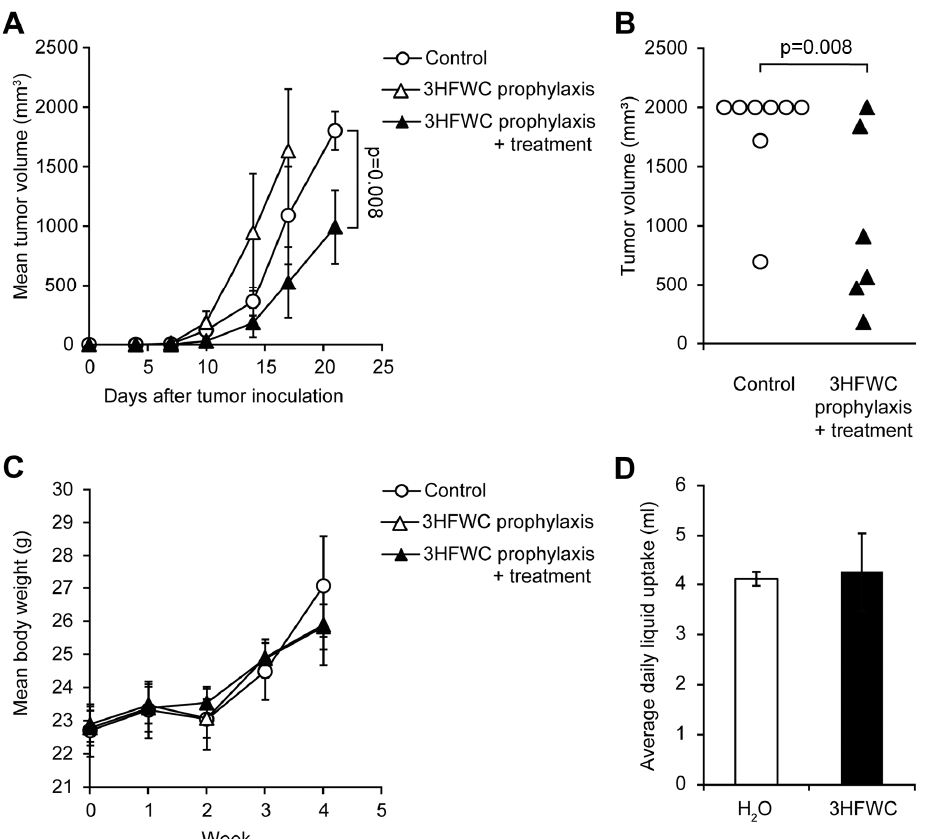
Figure 6. Evaluation of prophylactic potential, and combined prophylactic and therapeutic poten- tial of 3HFWC to suppress B16 growth in vivo . B16 mouse melanoma cells (2 × 10 5 ) were s.c. inocu- lated into C57BL/6 mice on day 0. Mice were treated with 3HFWC from day -7 till day 0 (3HFWC prophylaxis), from day -7 till the end of the experiment (3HFWC prophylaxis + treatment) or were left untreated (control). ( A ) Growth curves depicting average tumor volumes; ( B ) individual tumor volumes at the end (day 21) of the representative experiment; ( C ) mean body weight, and ( D ) average daily liquid (water of aqueous 3HFWC solution) uptake of each group. Data are presented as mean ± SEM and compared with the control group, Mann–Whitney test.